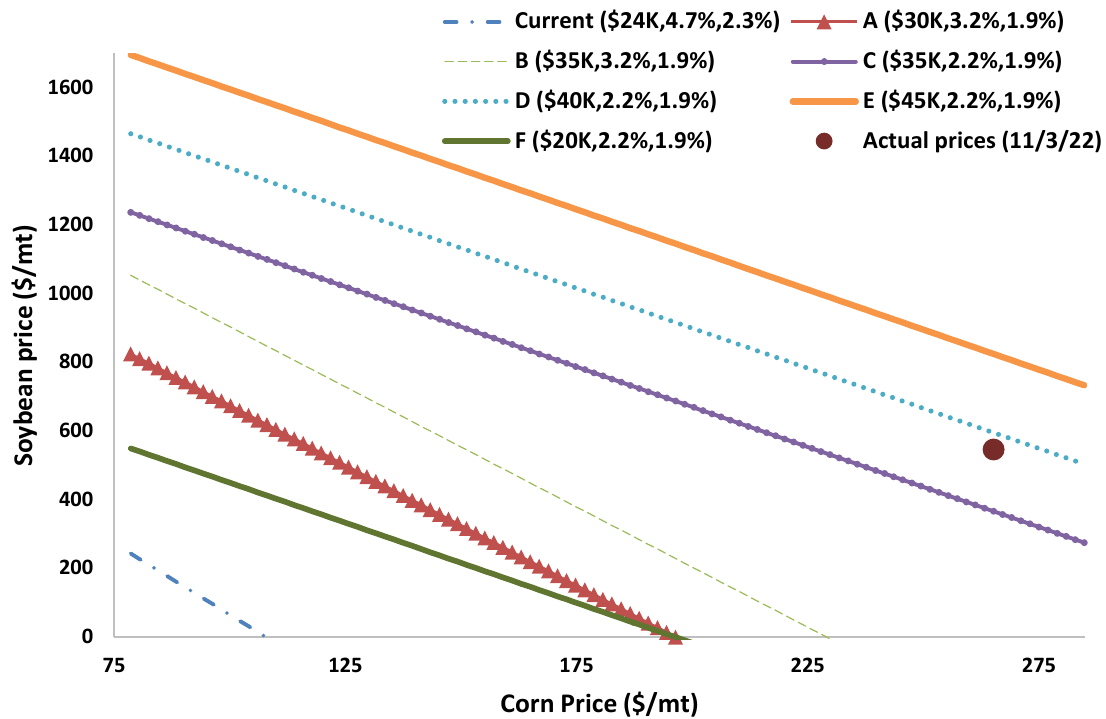
Figure 3. Graphs of breakeven corn and soybean prices for no-till as compared to the baseline under alternative yield penalty and cost reduction assumptions.